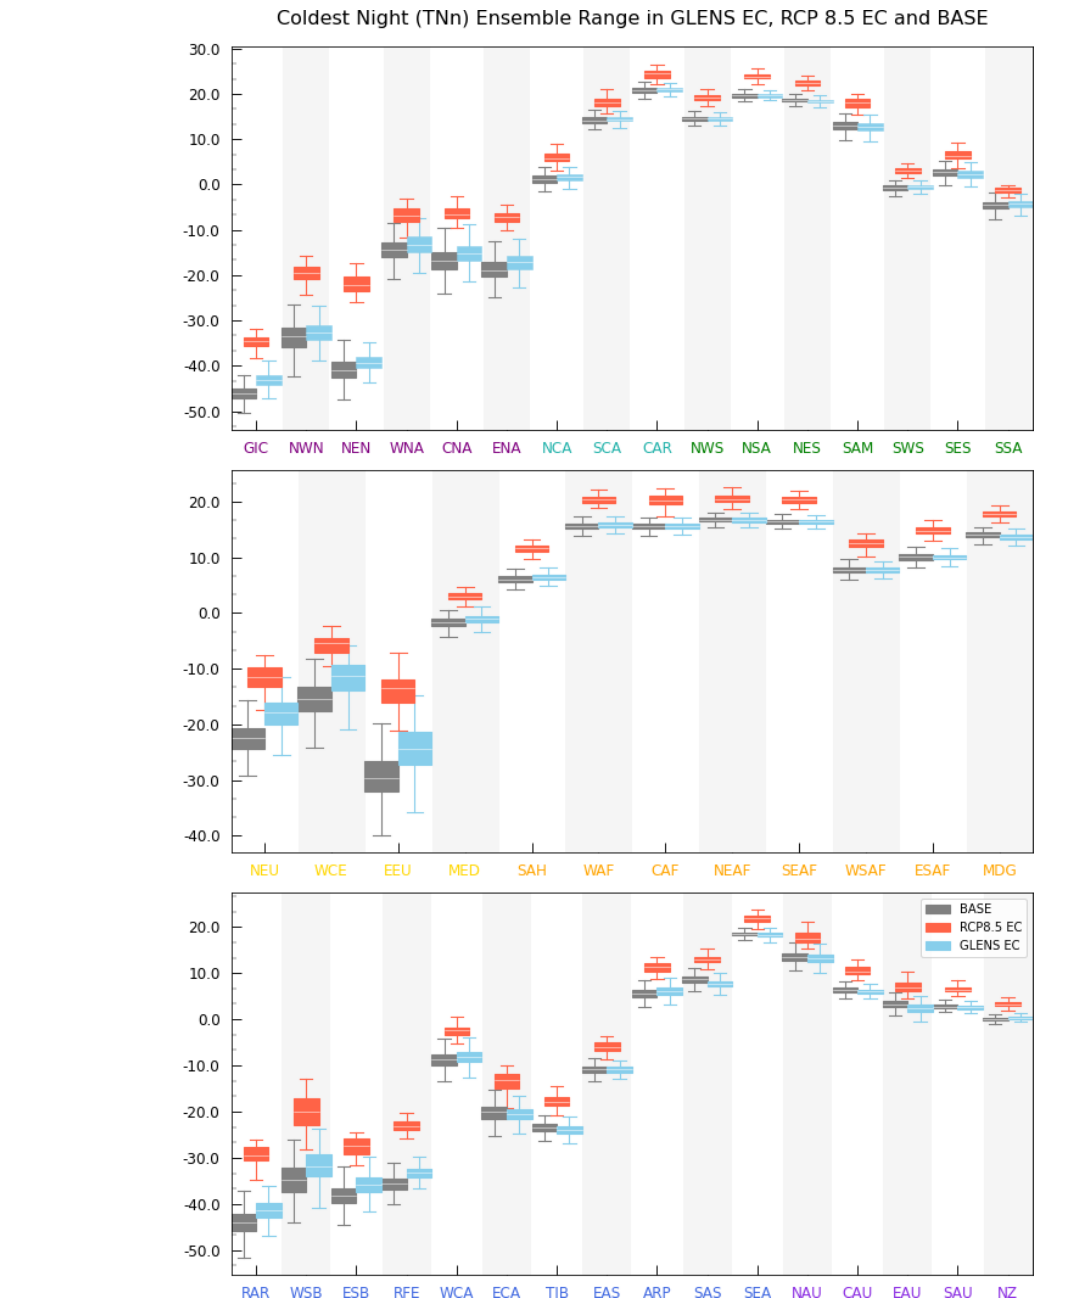
Figure 3. Climatological mean of the coldest night (TNn) for BASE (2010–2030) in gray, GLENS end of century (EC; 2075–2095) in blue, and RCP8.5 EC in red in each of the AR6 regions except Antarctica (Iturbide et al., 2020). Boxes show the ensemble mean in white with the limits set at 25% and 75% of the ensemble spread; whiskers denote 5% and 95% ensemble